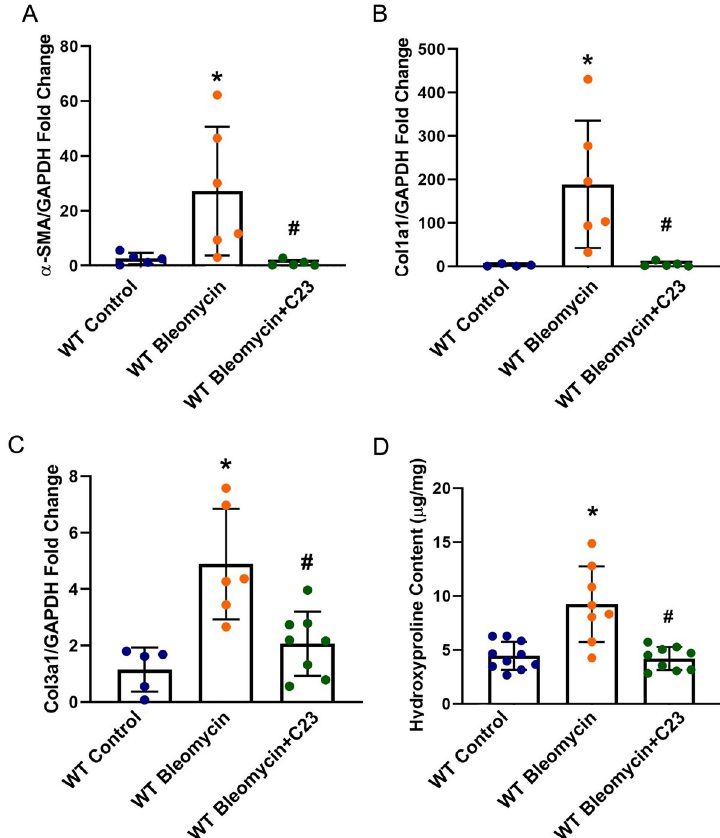
Fig 4. The eCIRP antagonist C23 ameliorates molecular markers of fibrosis in mice exposed to bleomycin. For α - SMA ( A ), Col1a1 ( B ), and Col3a1 ( C ) mRNA expression data, total RNA was isolated using Trizol reagent and reverse transcribed to cDNA using M-MLV (Moloney murine leukemia virus) reverse transcriptase. Glyceraldehyde 3-phosphate dehydrogenase (GAPDH) RNA was used to normalize the amplification data and fold changes were calculated in comparison with WT Control mice, using the 2 (- ΔΔ Ct) method. For the hydroxyproline assay, the calorimetric Hydroxyproline assay was used to measure hydroxyproline content ( D ) from samples prepared from ~100 mg of lung tissue lysates from each mouse. � p < 0.05 vs. Wild Type (WT) Control, # p < 0.05 vs. WT Bleomycin. Data were analyzed using one-way analysis of variance (ANOVA) followed by Tukey’s multiple comparison test. WT Bleomycin and WT Control groups are identical to that of Fig